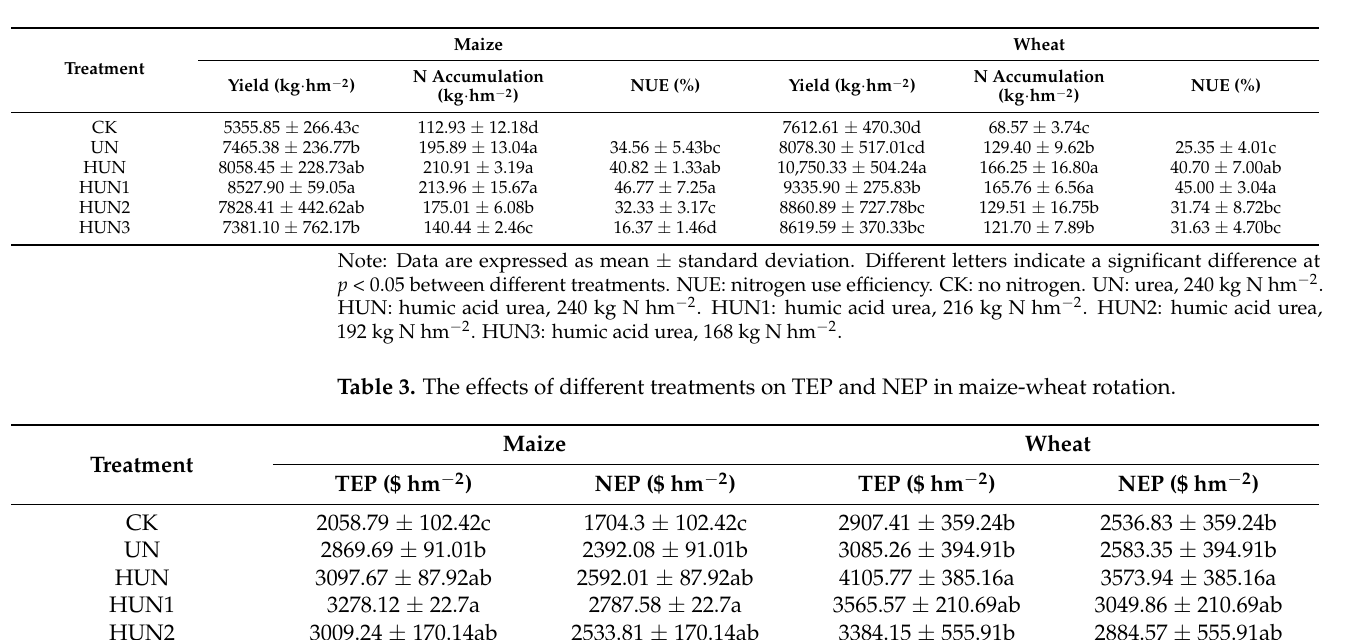
Table 2. The effects of different treatments on yield, nitrogen accumulation and NUE in maize- wheat rotation.